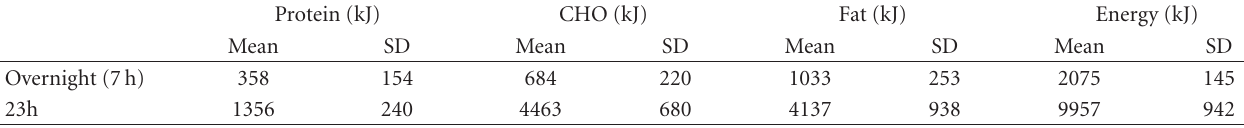
Table 3: Macronutrient oxidation and energy expenditure—means for all subjects in the untreated condition. Protein